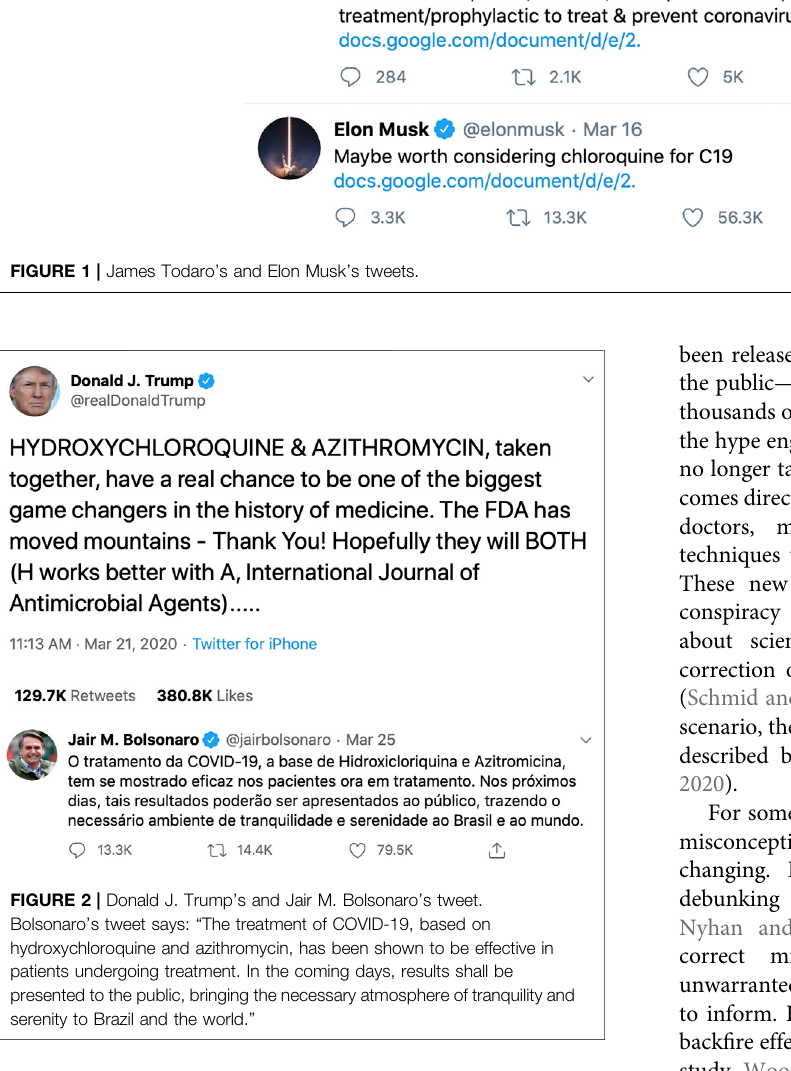
Frontiers in Communication |